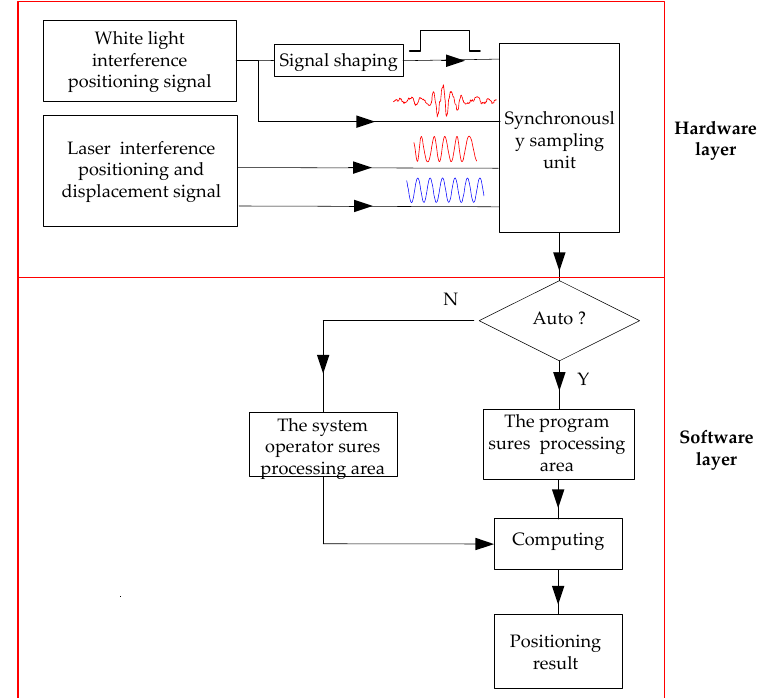
Figure 13. Block diagram of signal processing system.